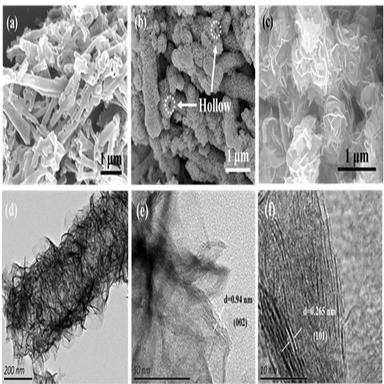
SEM images of g-C3N4-NT (a), MoS2-NT (b) and pristine MoS2 (c), and TEM images of MoS2-NT (d–f).